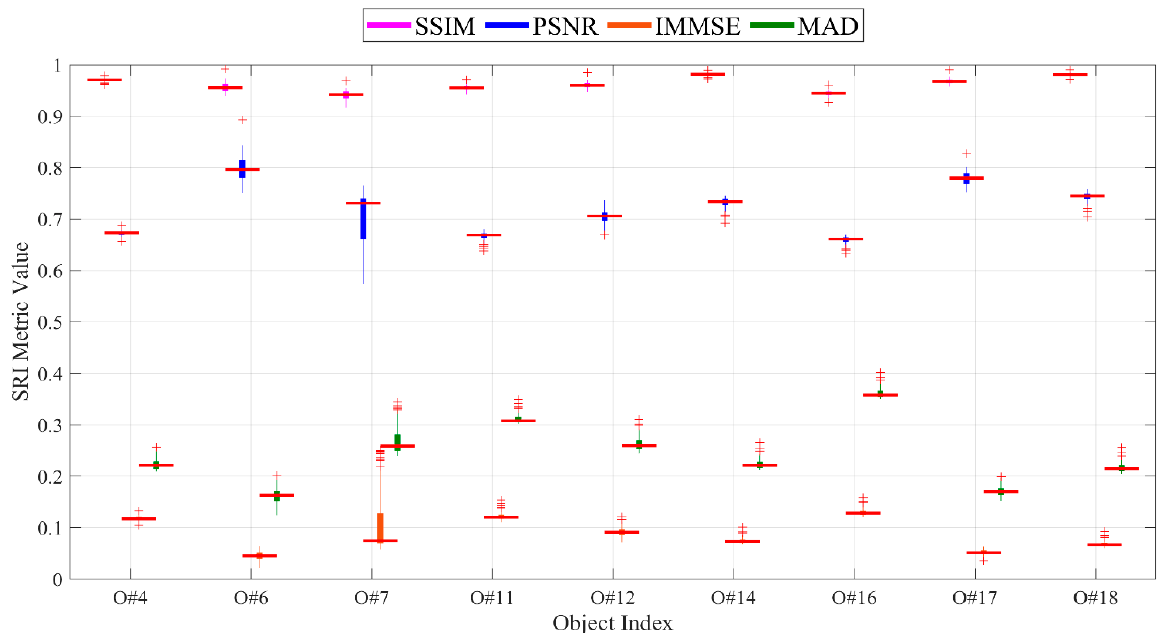
Figure A4. Evaluation results for SRI performances of proposed method for 122 specular reflection suppressed images (121 sub-aperture + 1 maximum ones) of nine sample objects separately using different SRI metrics.